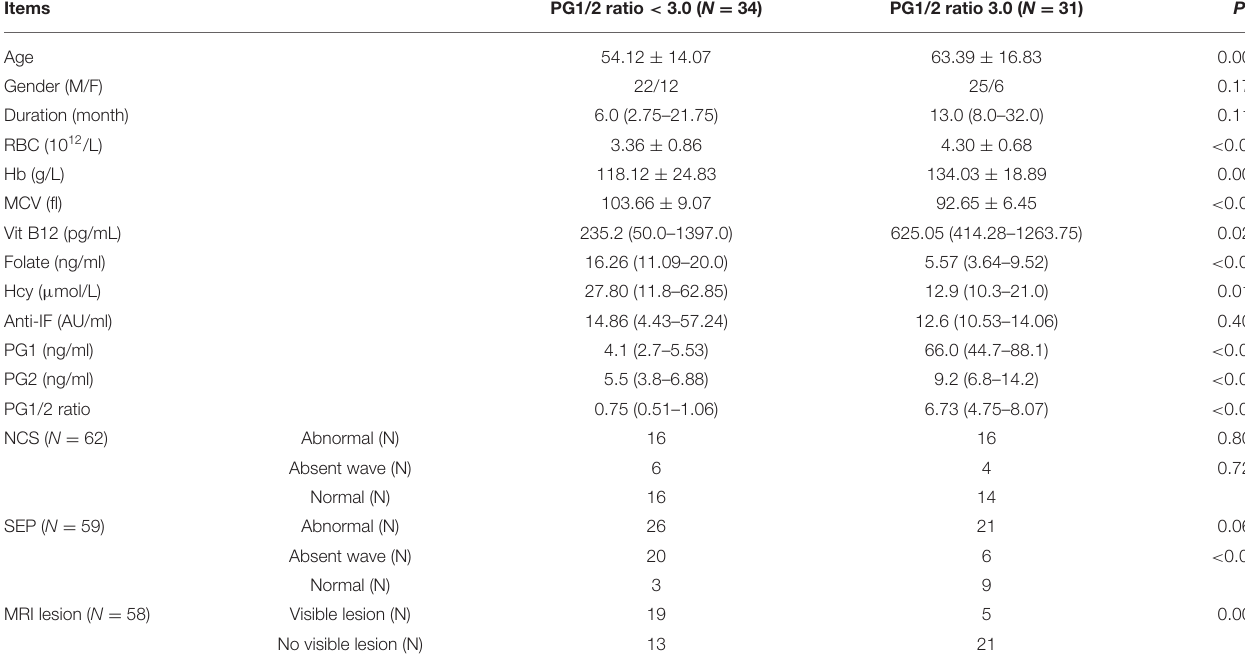
TABLE 1 | Clinical variables of SCD subgroups with normal or abnormal PG1/2 ratio. Items